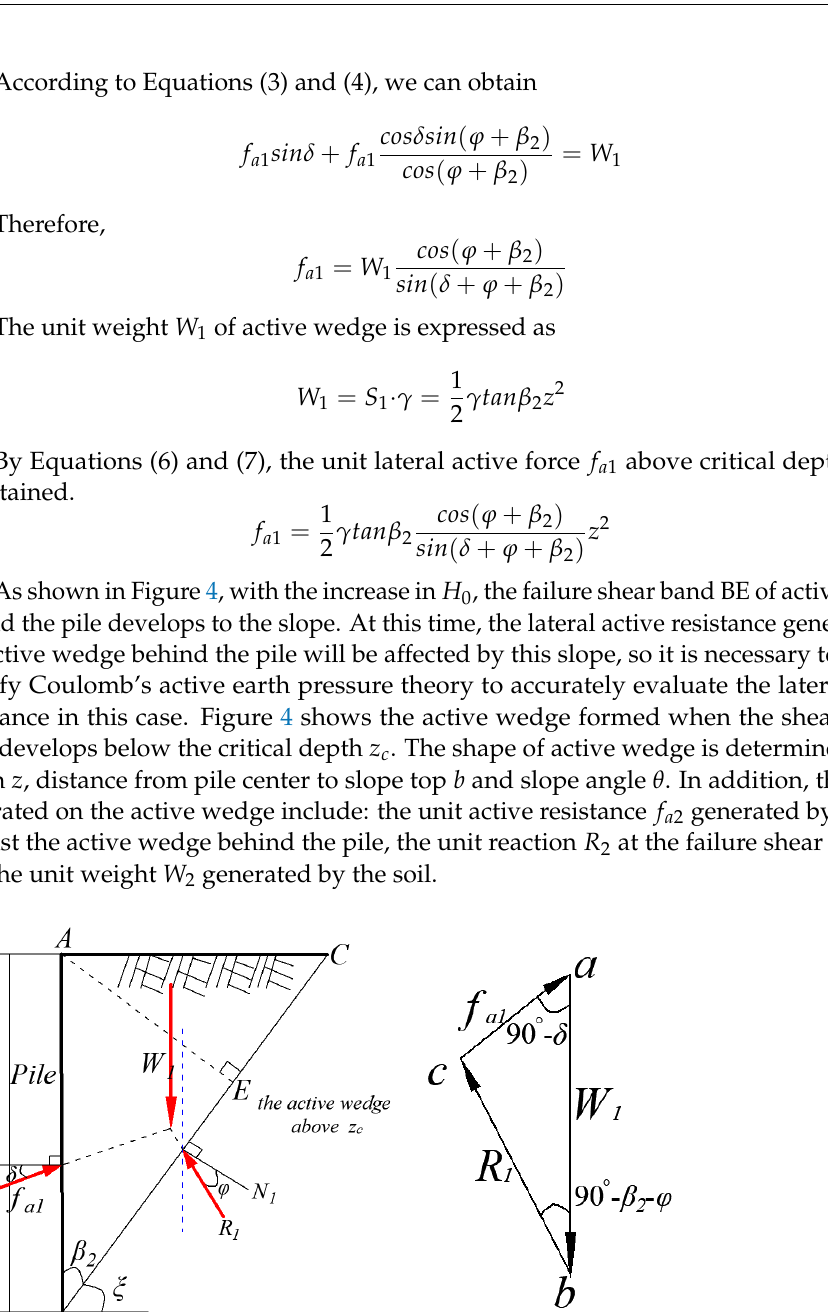
c and the system of